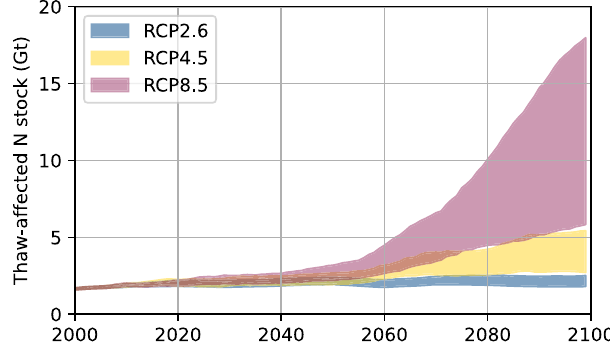
Fig. 5 | Projection of thaw-affected N stocks. The model estimate for thaw- affected C stocks by Nitzbon et al. 29 was adjusted to our N stocks by scaling simulated thaw depths under consideration of excess ice melt with the total areal extent of three geomorphological units composed of fi ve stratigraphical classes (see Table 1, Fig. 2).Foreach warmingscenariotheindicated rangescorrespondto 11-year running means of the annual maximum of thawed N under contrasting hydrological